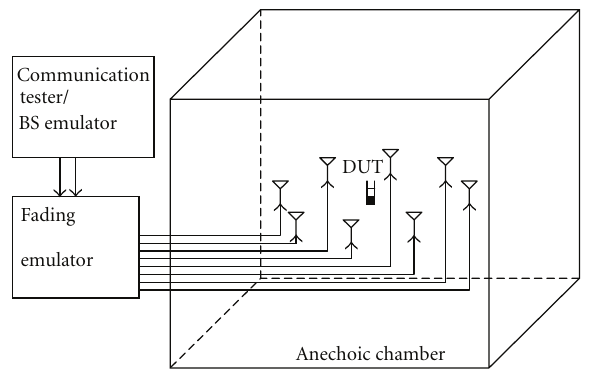
Figure 1: Illustration of a MIMO-OTA test system based on multi- probe